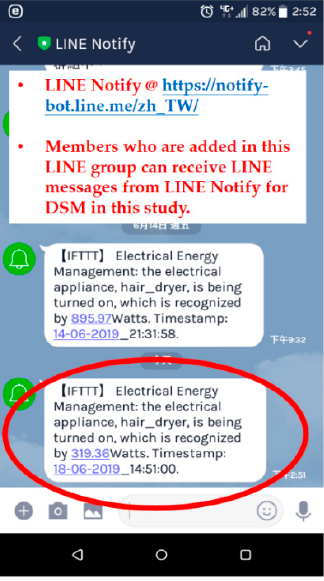
Figure 14. Load event message received by a LINE-Notify mobile phone over the IFTTT paradigm with Webhooks. A prespecified appliance event was identified and triggered for the monitored hair dryer.